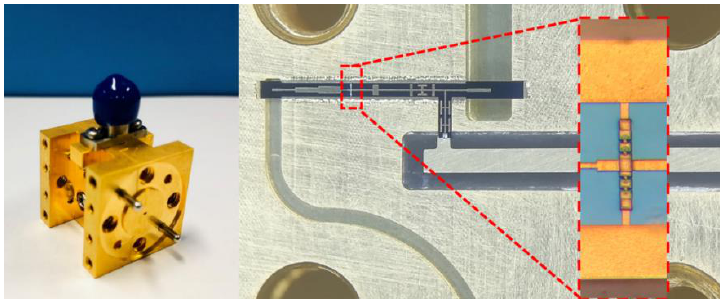
Figure 5. Photograph of the assembled tripler block connected with the SMA-connector for DC bias (left). Picture of the fabricated THz GaAs monolithic integrated tripler circuit installed in a split block with the enlarged view of the diode chip (right).